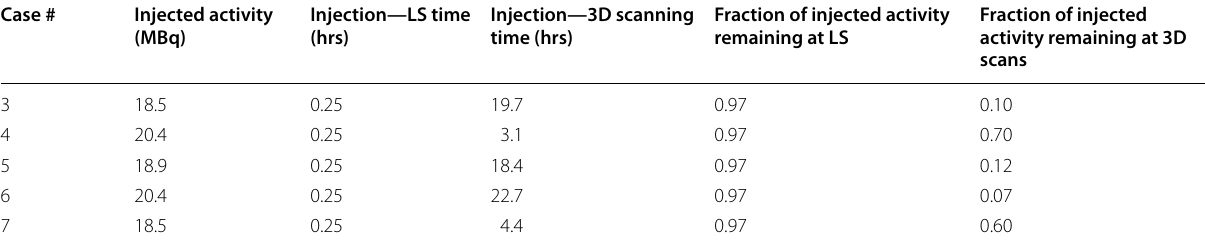
The two 3D scans (camera fhSPECT and probe fhSPECT) were performed with no lapsed time between them, so their injection-to-scan time was identical). LS lymphoscintigraphy; 3D scans camera fhSPECT and (when performed) probe fhSPECT = =